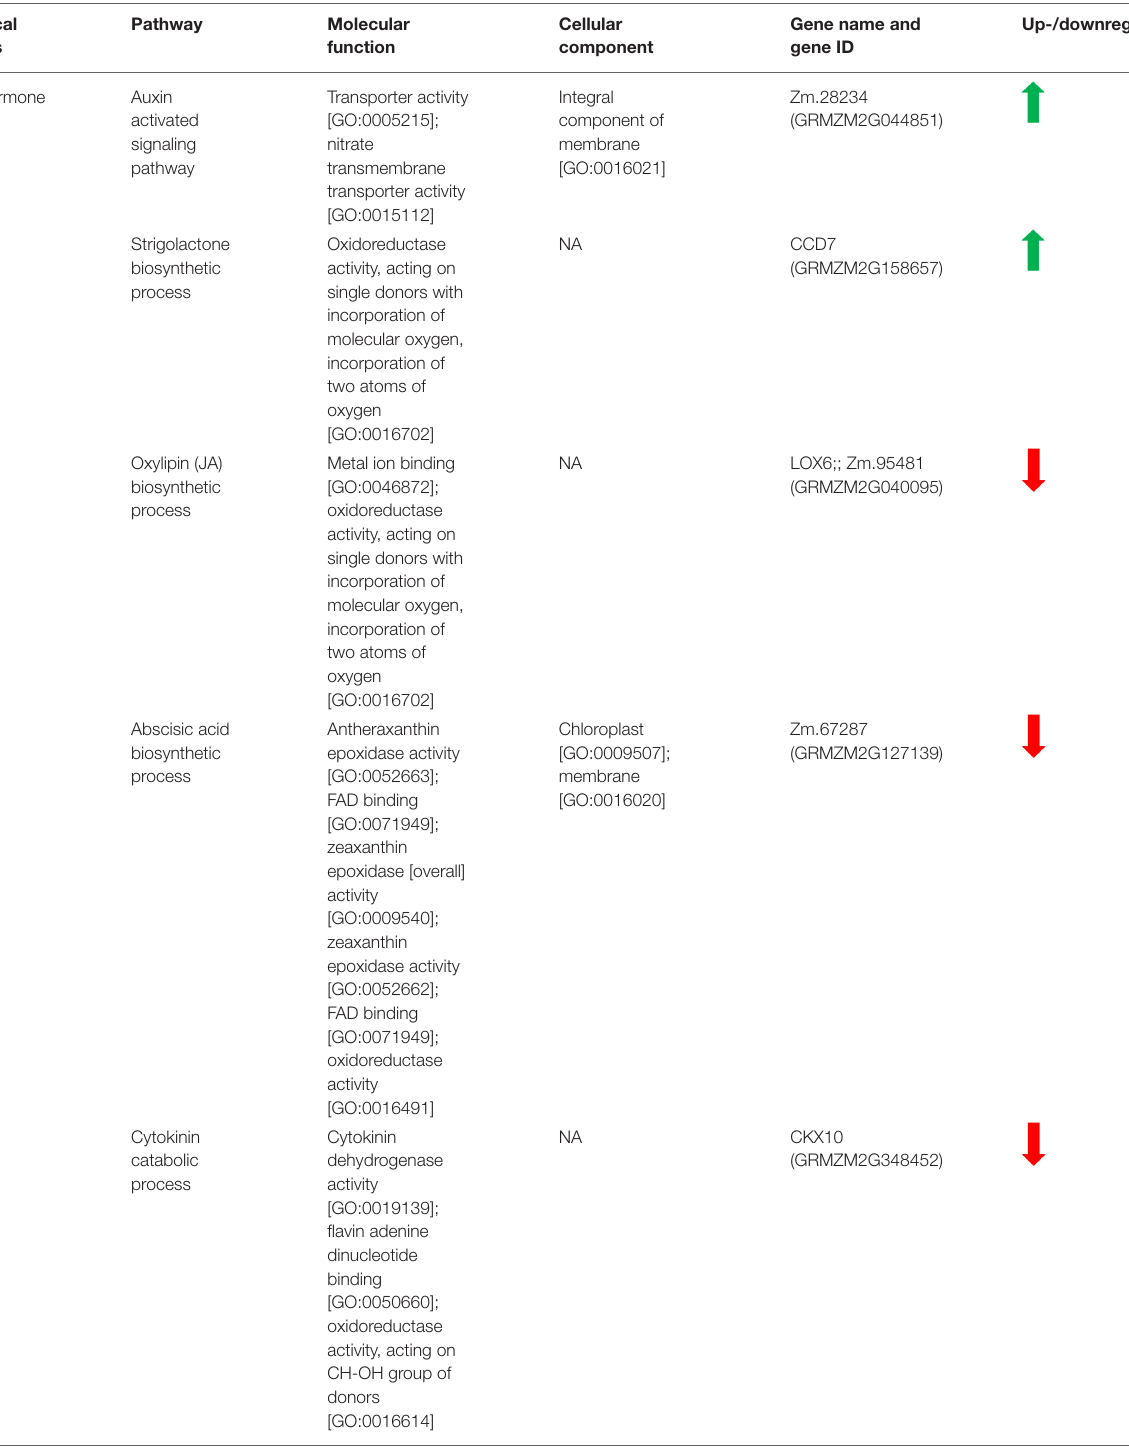
TABLE 3 | Classification of upregulated (log2FC ≥ 2) and downregulated (log2FC ≤ − 2) genes (at p -value ≤ 0.001) based on biological process and pathway in which they are involved. Biological